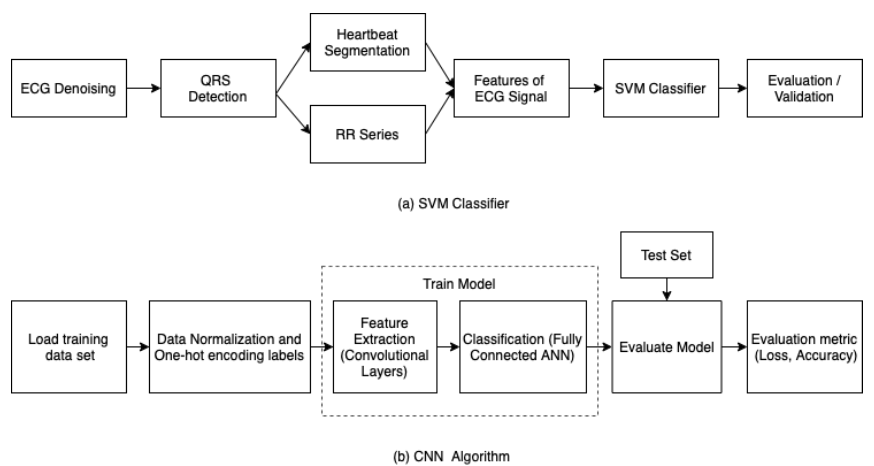
Figure 1. Automatic ECG signal analysis diagram with ( a ) SVM classifier [2] and ( b ) CNN Algorithm. ( a ) Steps for classification with SVM classifier. ( b ) Steps for classification with Convolutional Neural Network (CNN).